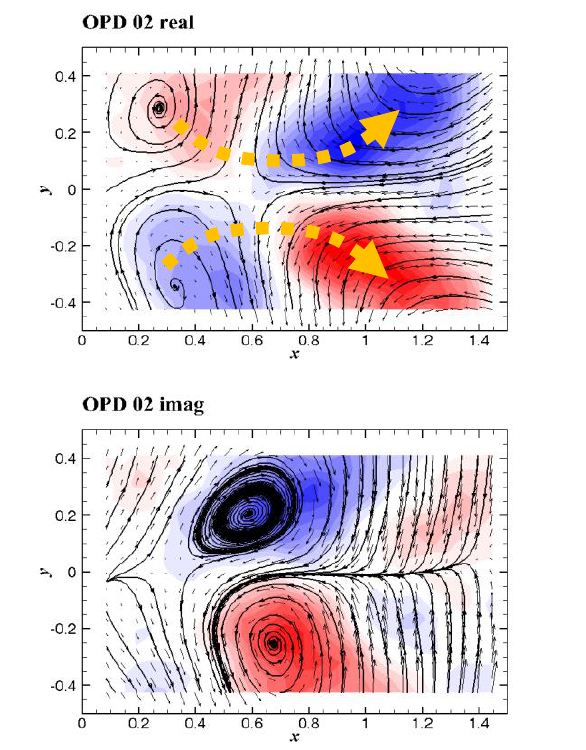
Fig. 11. Topology of the 2 nd OPD mode, real and imaginary parts .